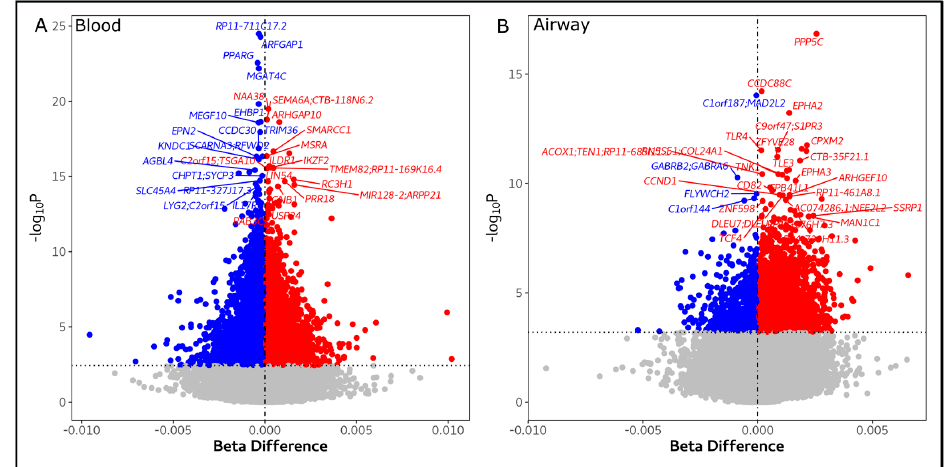
Figure 1. Blood ( A ) and airway ( B ) differentially methylated sites association with Total SGRQ score. x-axis represents the robust linear model (rlm) estimated effects on the methylation Beta-values, y-axis represents the rlm − log10P on M-values. For each unit of SGRQ increased, DNA methylation decreases (hypomethylation = blue) or increases (hypermethylation = red).